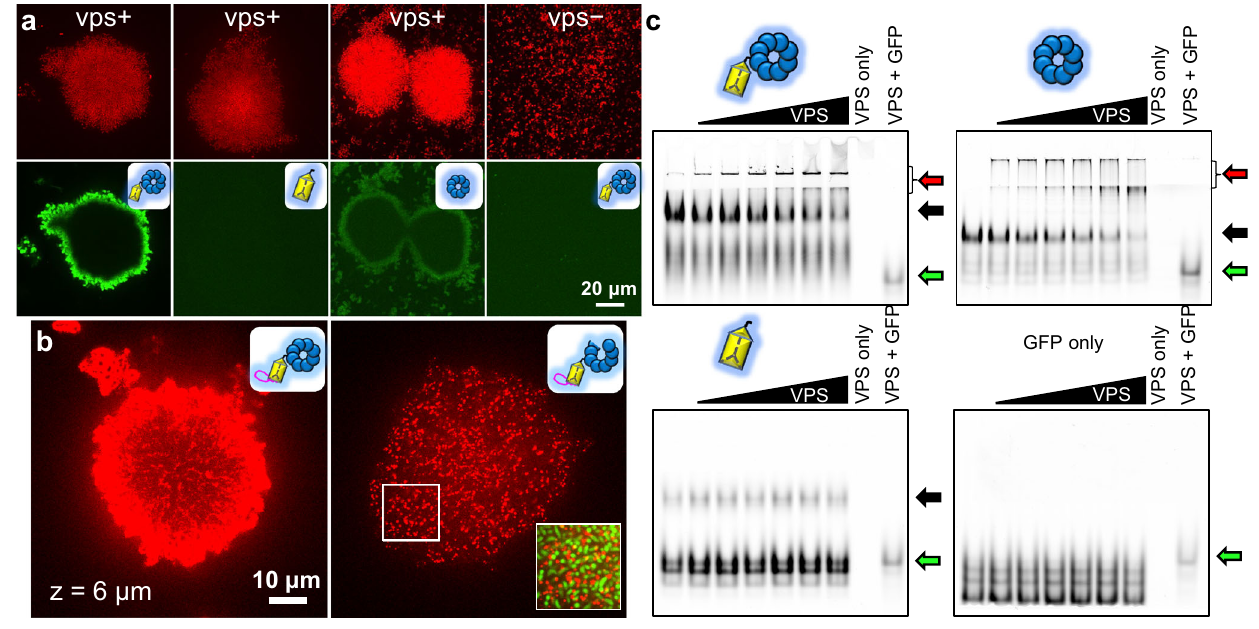
Fig. 2 | A conserved β -propeller domain anchors Bap1 and RbmC to VPS. a V. cholerae bio fi lmsexpressingmScarlet-I( Top )incubatedwith1 μ Mpuri fi edandGFP- tagged proteins ( Bottom ) with the indicated domain(s). The VPS − control was per- formed with Δ vpsL cells unable to produce VPS. b Cross-sectional images (at z =6 μ m) of bio fi lms from cells expressing wild-type Bap1 ( Left ) and Bap1 Δ Velcro ( Right ), both tagged with a 3×FLAG tag at the C-terminus and stained with an anti- FLAGantibodyconjugatedtoCy3.Inset:magni fi edimageoftheregionhighlighted